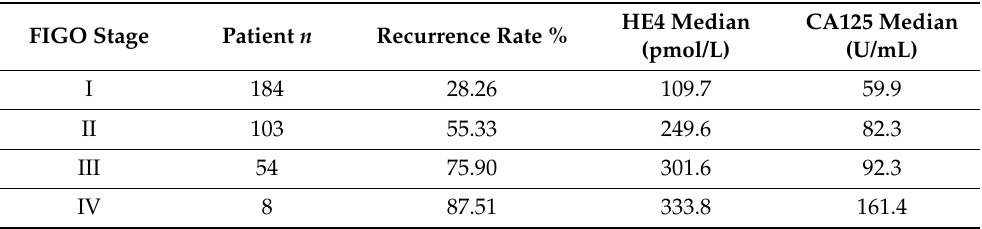
Figure 5. CA125 levels in relation to recurrence. Table 3. FIGO stage and recurrence.